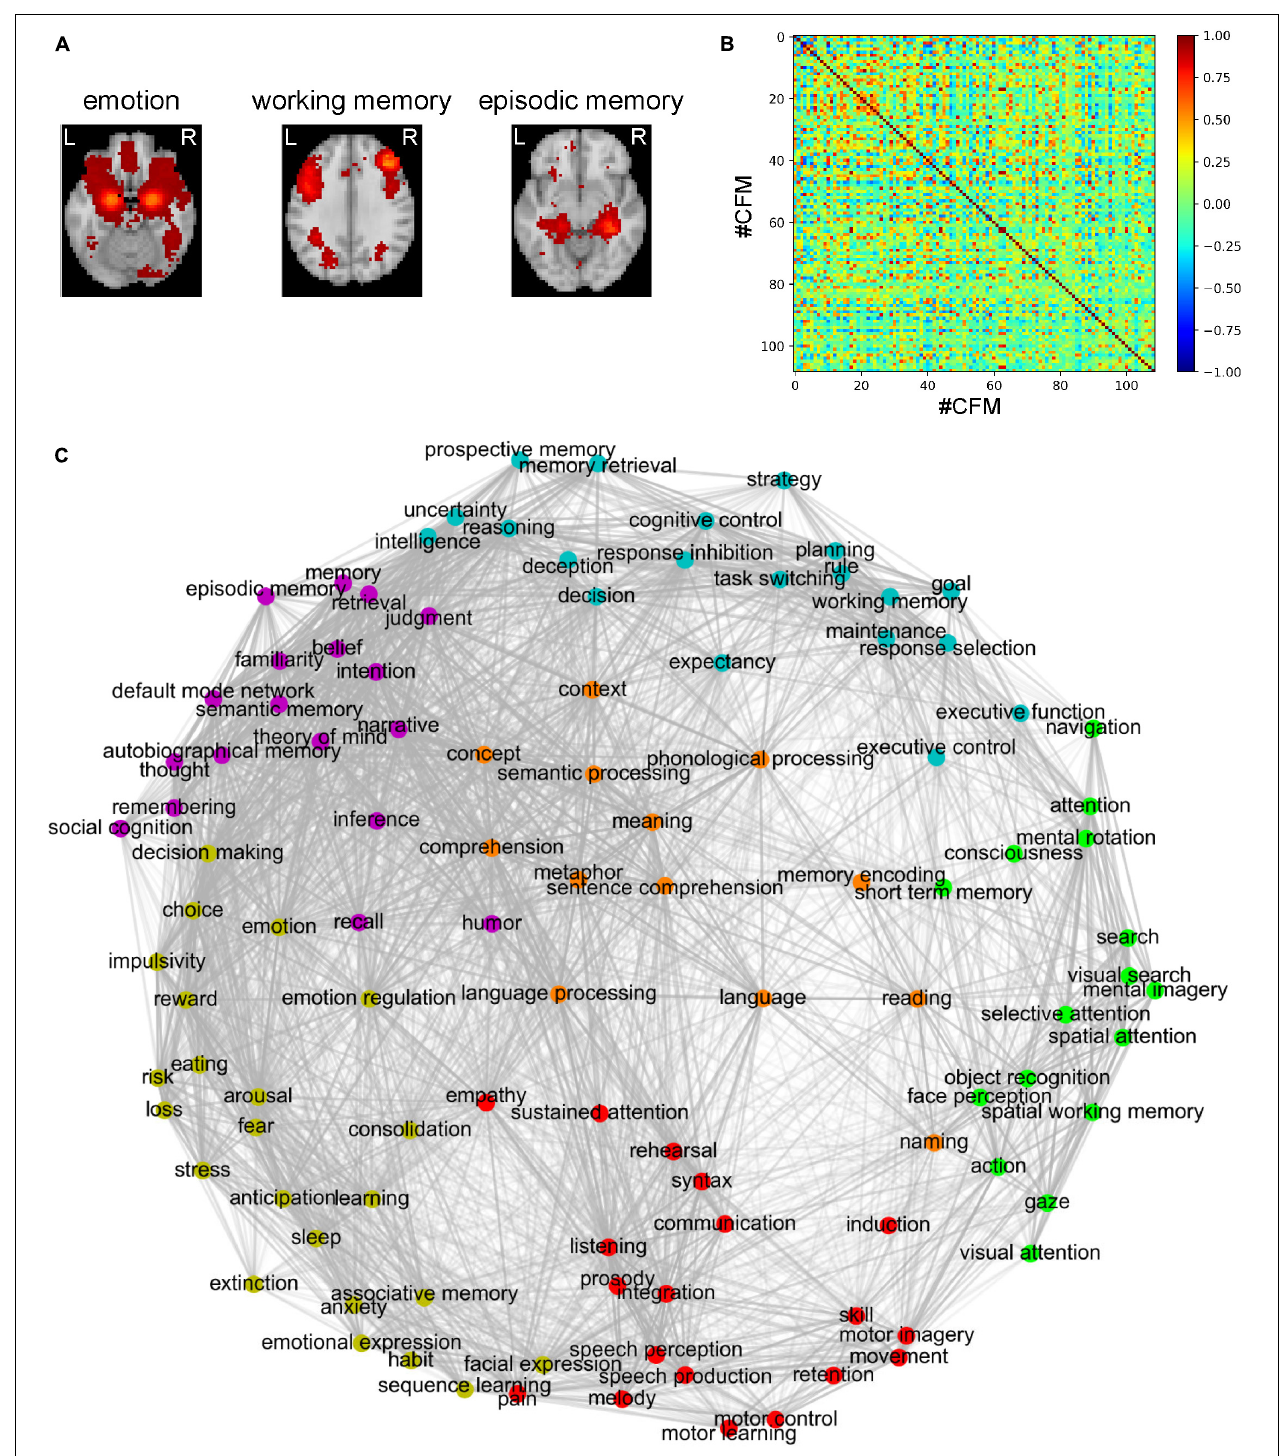
FIGURE 1 | Relational mapping and clustering of cognitive functions based on the cognitive function map (CFM)-to-CFM resting-state functional connectivities (RSFCs). (A) Examples of the reconstructed CFMs. (B) The CFM-to-CFM RSFC matrix. (C) Relational mapping of cognitive functions. The locations of cognitive functions in the two-dimensional plane were determined by applying multidimensional scaling to the CFM-to-CFM RSFC matrix. Furthermore, spectral clustering was applied and resulted in six clusters of cognitive functions, in which, roughly, the red-purple cluster included ‘self and others’-related functions, the blue cluster included ‘executive function’-related functions, the orange cluster included ‘language’-related functions, the yellowish-green cluster included ‘value and judgment’-related functions, the red cluster included ‘action and expression’-related functions, and the green cluster included ‘vision and attention’-related functions.